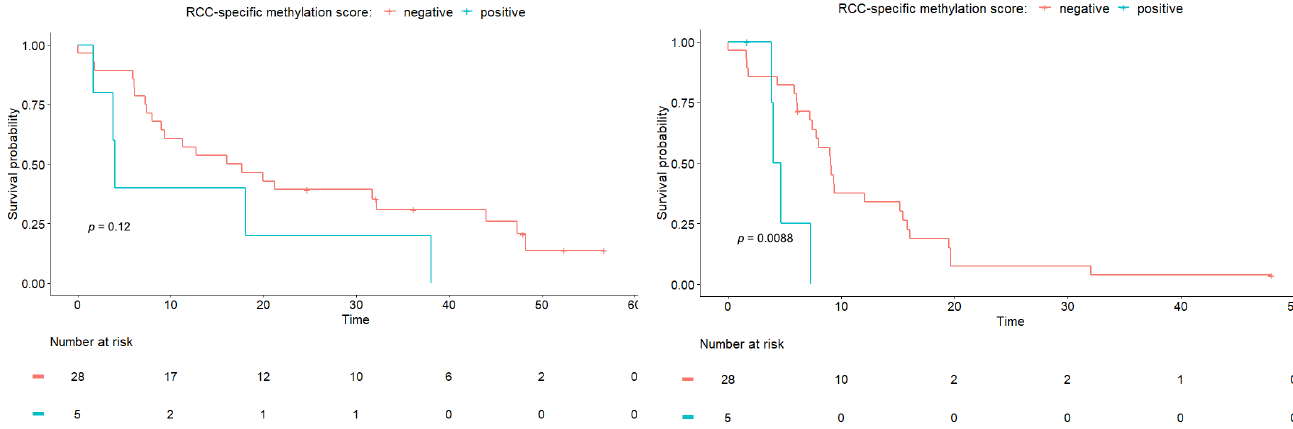
Figure 3. Kaplan Meier analyses for WW time ( left ) and PFS time ( right ). Patients are divided based on RCC-specific methylation score. A log-rank test was performed to compare the curves.